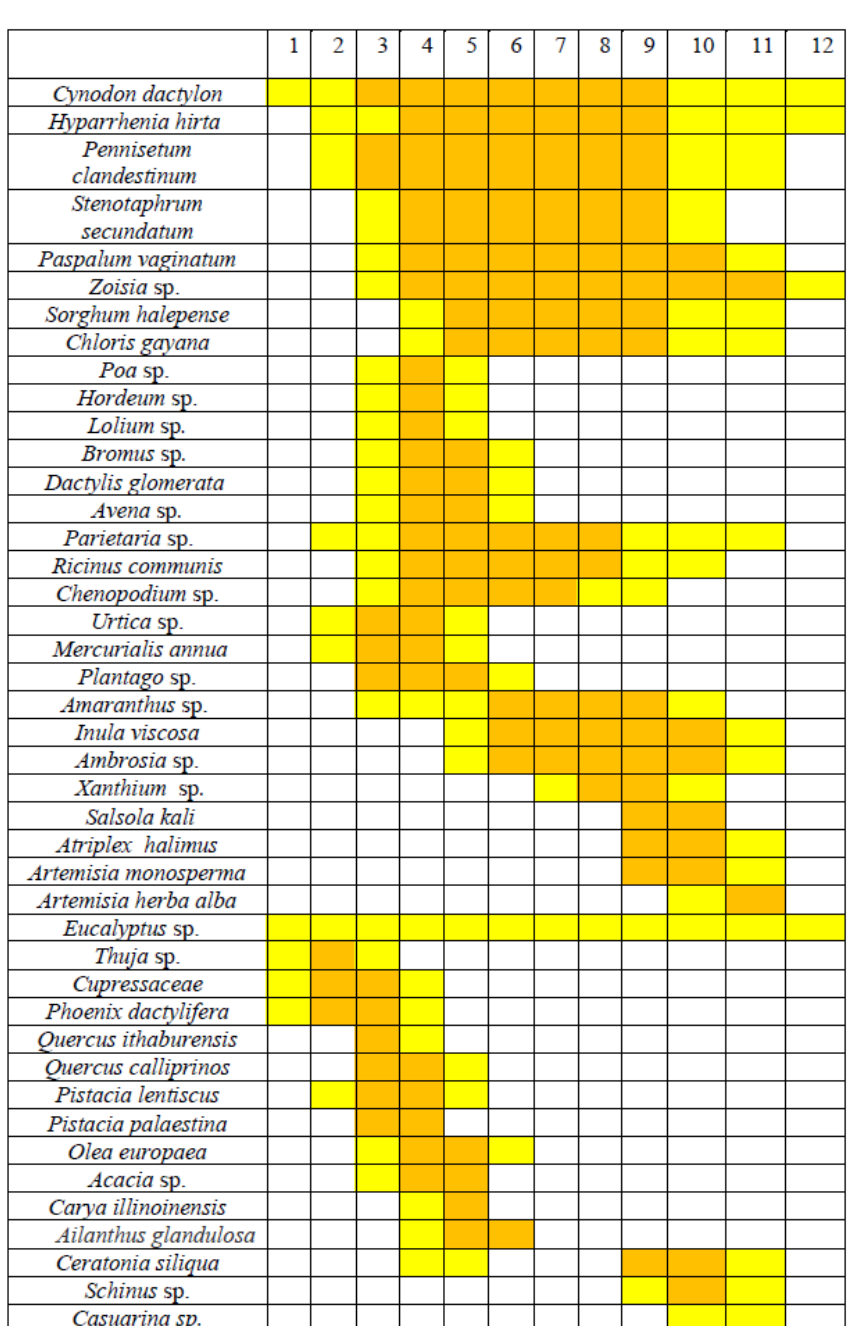
Table A1. Table showing flowering months for various allergenic plants in Israel (based on Keinan, 1992). Yellow marks little flowering, dark brown marks massive